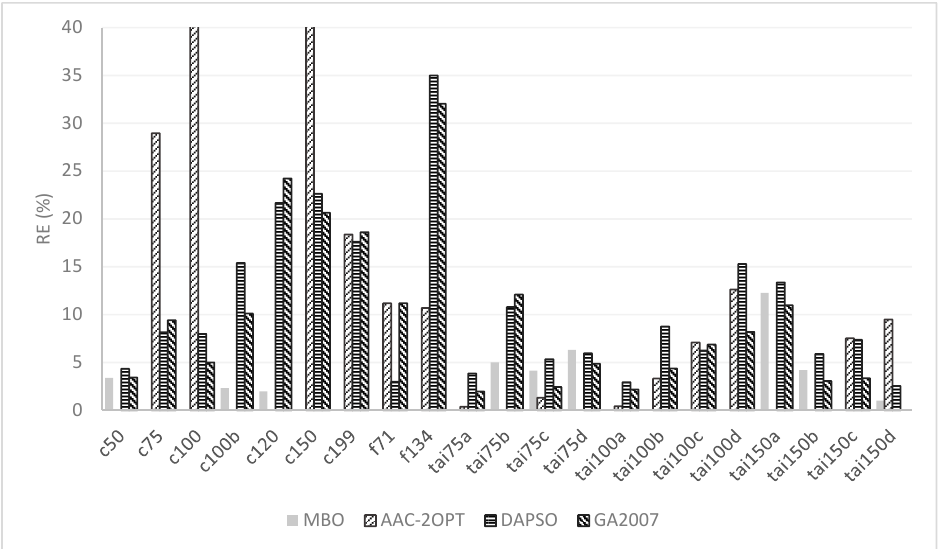
Figure 4. Deviation from the known optimal solution. Algorithms 2017 , 10 , 107